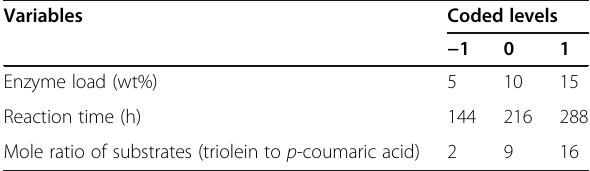
Table 1 Independent variables in the experimental design Variables Coded levels − 1 0 1 Enzyme load (wt%) 5 10 15 Reaction time (h) 144 216 288 Mole ratio of substrates (triolein to p -coumaric acid) 2 9 16